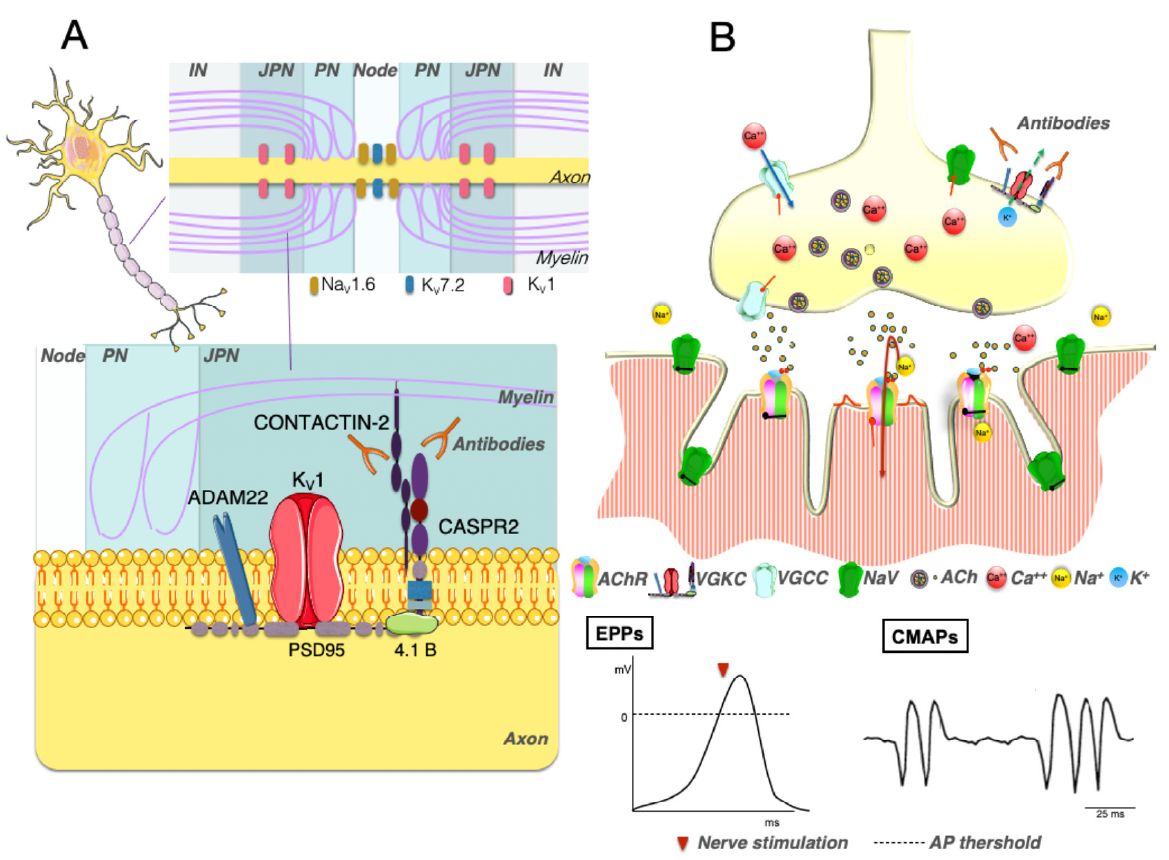
Figure 3. Pathophysiology of neuromyotonia. ( A ) Schematic overview of the VGKC complex in the juxtaparanodal region of myelinated axons (modified from [144]). CASPR2, together with contactin-2 and other proteins, is fundamental for clustering Kv1 channels. CASPR2 antibodies could interfere with CASPR2-contactin-2 interaction leading to Kv expression down-regulation with consequent impairment of action potential repolarisation and excessive or prolonged release of acetylcholine. ( B ) This leads to prolonged EPP and repetitive nerve firing. The EMG shows myokymic discharges (doublets, triplets, and multiplets).